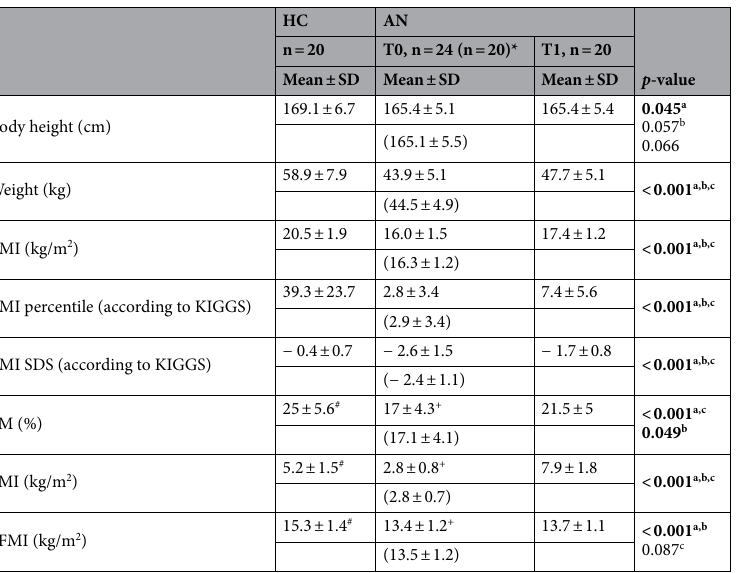
Table 1. Characteristics of the study sample. Significant effects are in bold print. HC healthy control, AN patients with Anorexia nervosa, BMI body mass index, SDS standard deviation scores, FM fat mass, FMI fat mass index, FFMI fat free mass index, KIGGS German Health Interview and Examination Survey for Children and Adolescents. P- values vs. HC were calculated by t test for independent samples, T0 vs. T1 by t test for paired samples. *20 AN patients with follow-up data, # n = 19, + n = 23 a HC vs. AN(T0). b HC vs. AN(T1). c AN(T0) vs.